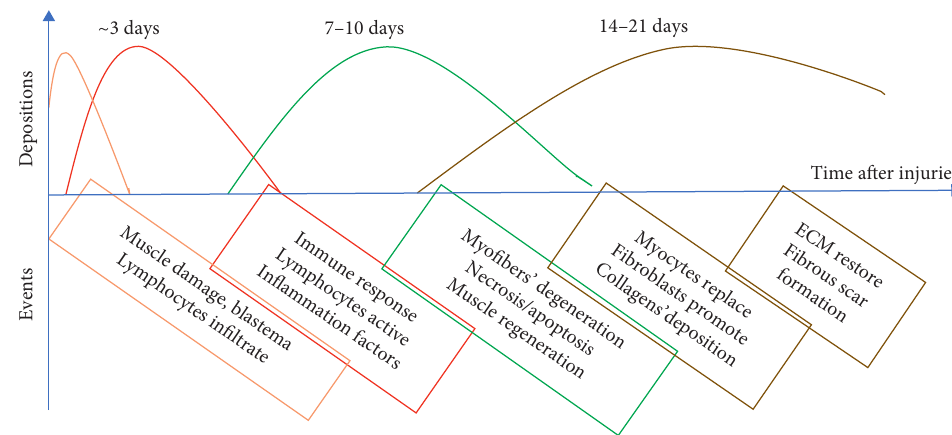
Figure 1: The time relation to muscle response after